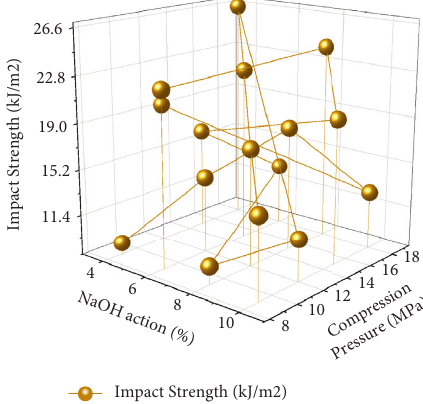
Figure 16: Impact strength: 3D trajectory plot of compression pressure and NaOH action.